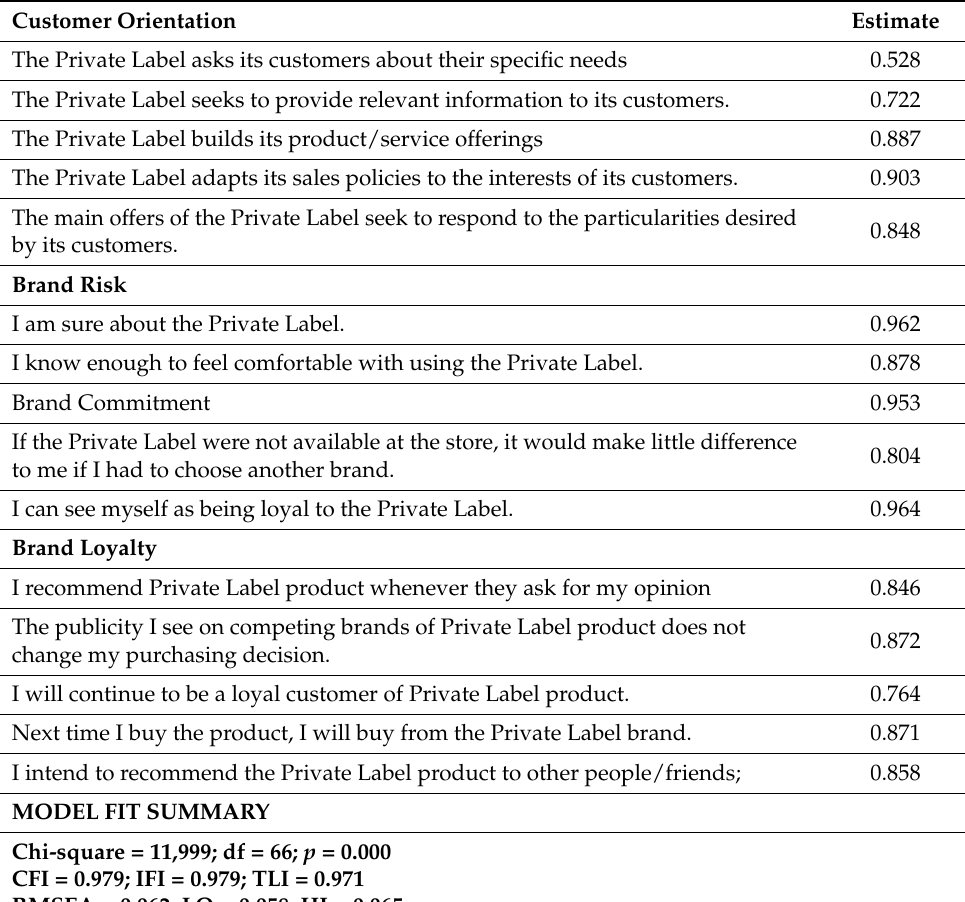
Table 6. Confirmatory Factor Analysis: convergent validity.